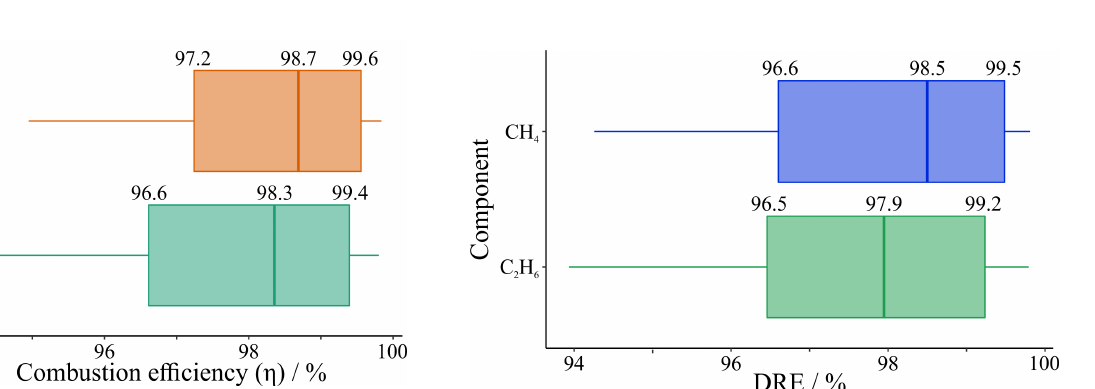
Figure C2. Box and whisker plots of destruction removal efficien- cies (DREs) for CH 4 (blue; top row) and C 2 H 6 (green; bottom